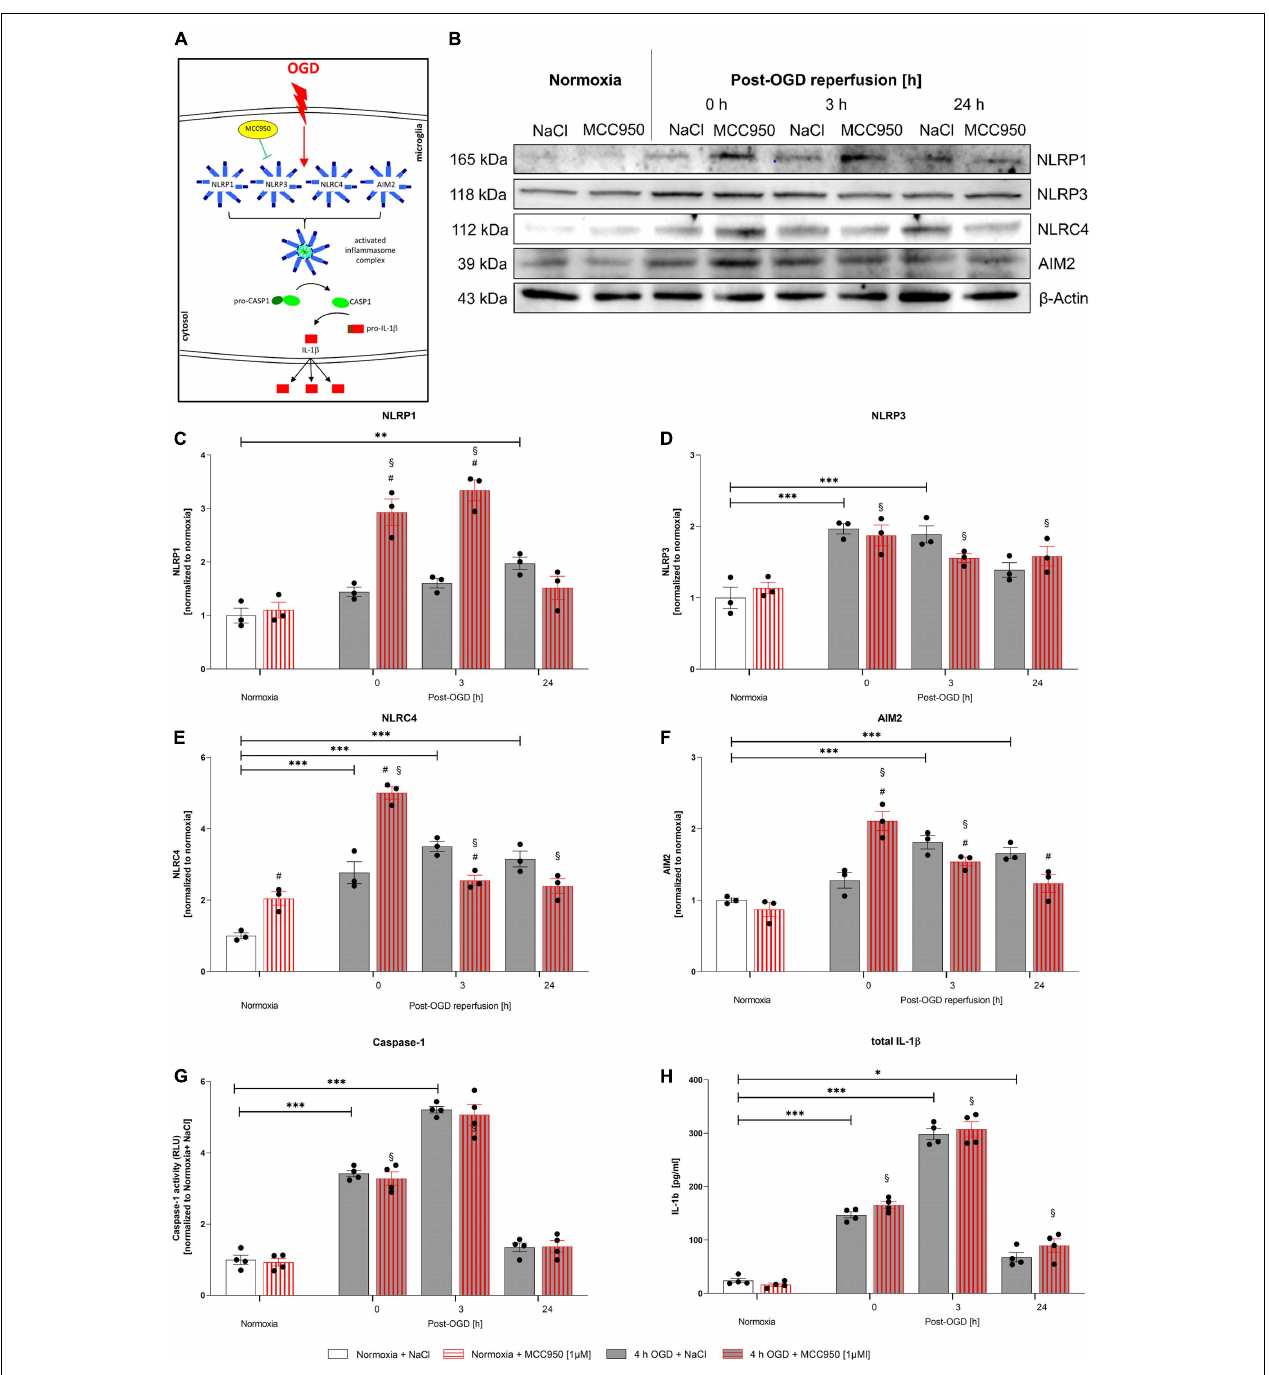
FIGURE 7 | Functional inhibition of NLRP3 inflammasome using MCC950 induces an upregulation of the NLRP1, NLRC4, and AIM2 inflammasomes after 4 h of OGD followed by a reperfusion period of 24 h. HMC-3 cells were treated with a single-dose of MCC950 [1 µ M] and subjected to 4 h of OGD followed by a reperfusion period of up to 24 h. (A) Schematic illustration of functional inhibition of the NLRP3 inflammasome upon OGD. (B) Representative Western blot images of NLRP1, NLRP3, NLRC4, AIM2, and β -Actin protein levels. (C–F) Densitometric quantification of protein levels normalized to saline normoxia control. β -Actin served as loading control. Intergroup differences were tested by ANOVA two-way followed by Tukey post hoc test (multiple comparison). Bars represent means ± SD of 3 individual experiments, individual data points are shown. ∗ p < 0.05, ∗∗ p < 0.01, ∗∗∗ p < 0.001 between groups, § p < 0.05 compared to normoxia + NaCl. # p < 0.05 compared to vehicle group. (G) CASPASE1 activity was assessed by CASPASE1-Glo R (cid:13) assay and normalized to normoxia saline control. (H) IL-1 β concentrations [pg/ml] in the supernatant of HMC-3 cells were determined by ELISA. Bars represent means ± SD of 4 individual experiments with 3 technical replicates in each experiment, individual data points are shown. ∗ p < 0.05, ∗∗ p < 0.01, ∗∗∗ p < 0.001 between groups, § p < 0.05 compared to normoxia + NaCl. # p < 0.05 compared to vehicle group.